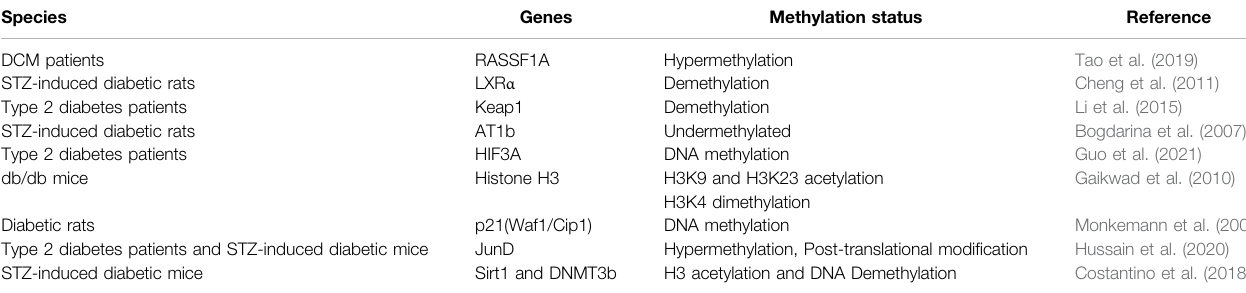
TABLE 1 | Summary of studies examining DNA methylation in DCM.